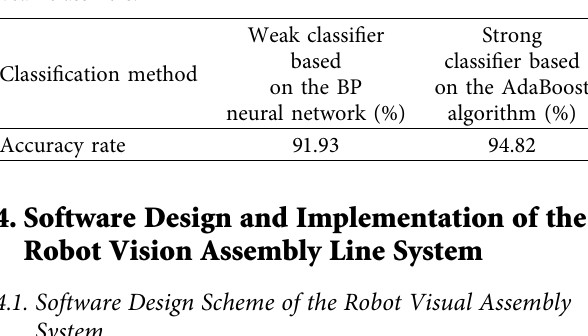
Table 4: Comparison of recognition efects between strong and weak